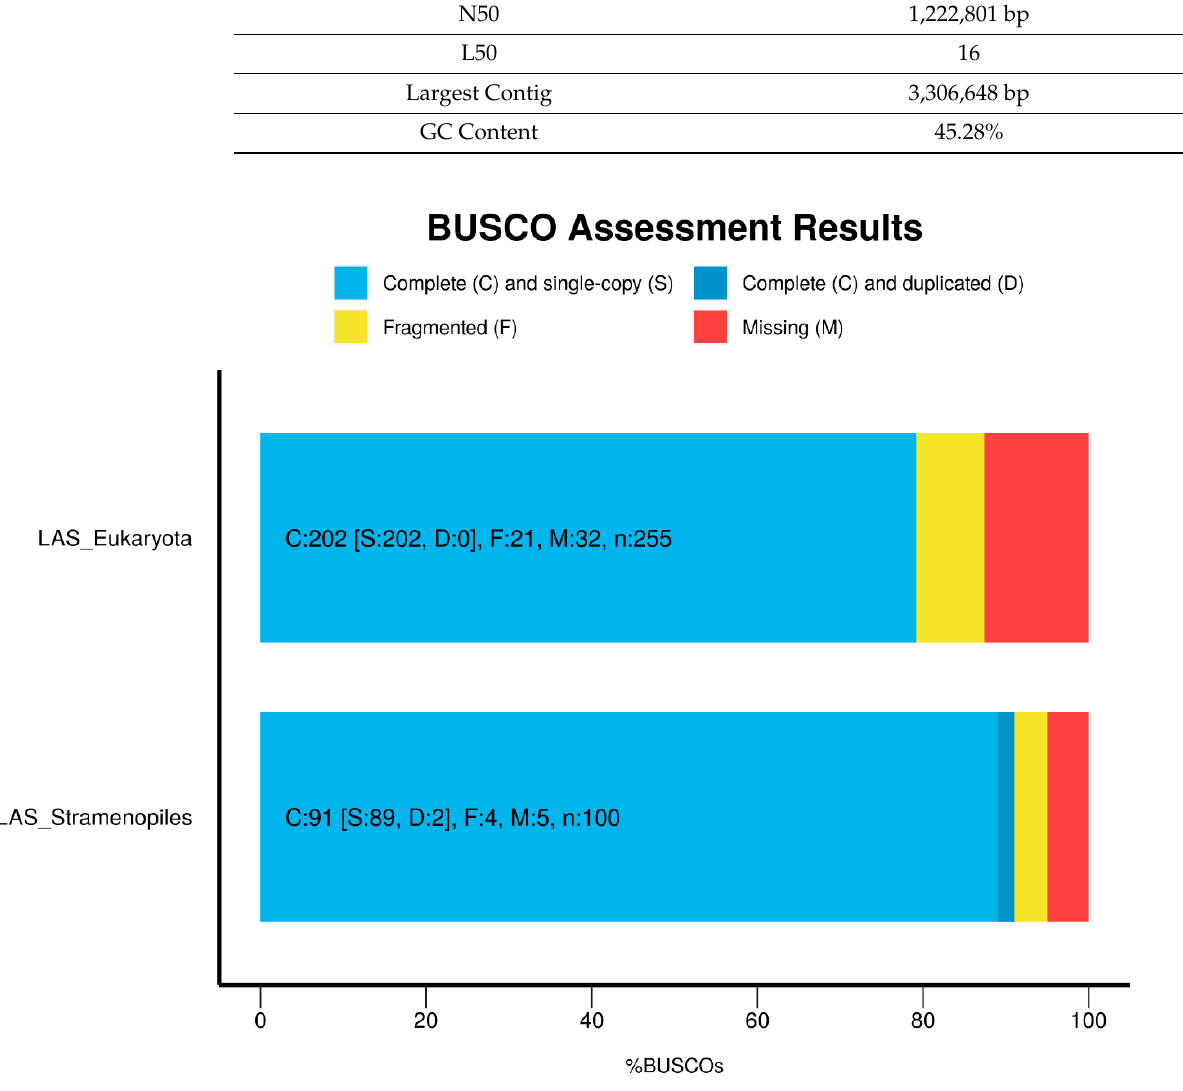
Figure A1. Results of the BUSCO analysis highlighting the presence of complete and single copy Eukaryotic and Stra- menopiles genes in the assembly. Letters indicate the BUSCO categories presented in the figure, numbers indicate the number of genes composing a category. ‘n’ indicates the total number of genes in all BUSCO